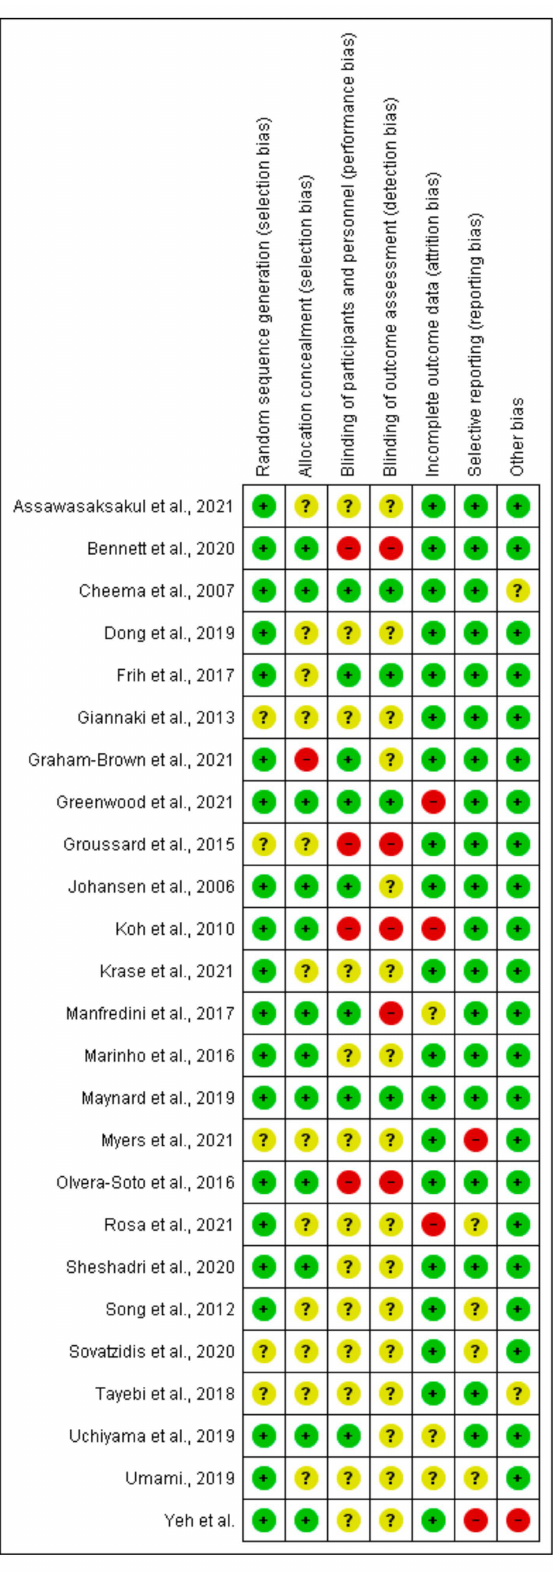
Figure A1. Exercise trials in the dialysis population